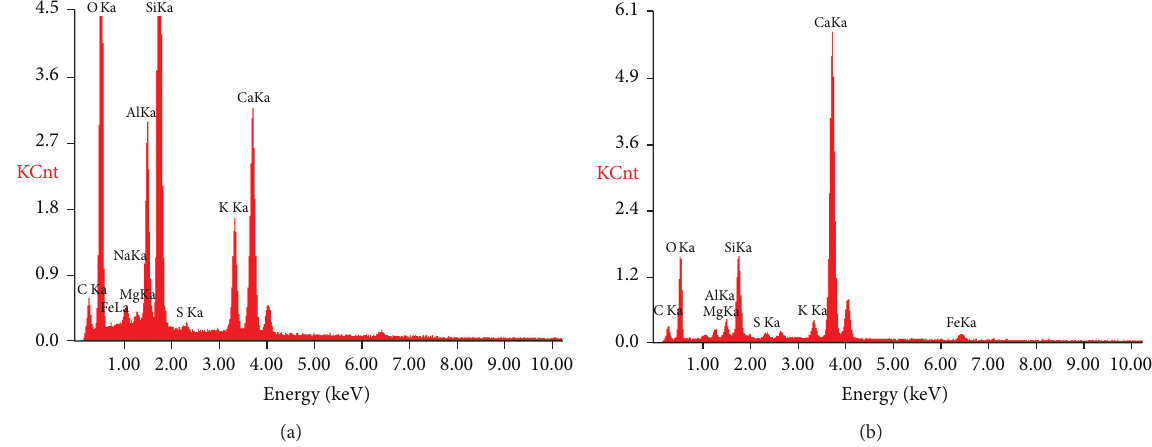
Figure 8: EDS analysis on concrete with LP at different hydration ages: 3 days (a) and 28 days